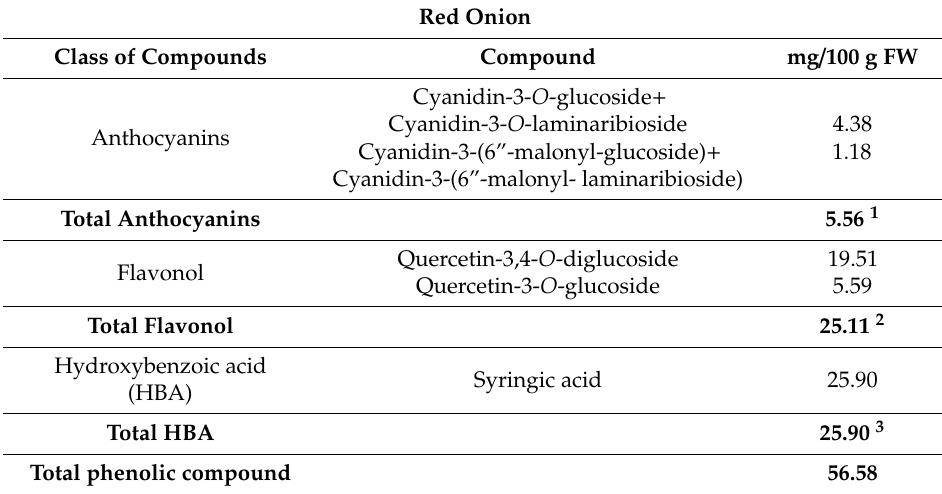
Table 9. Total polyphenolic compounds content in red onion.